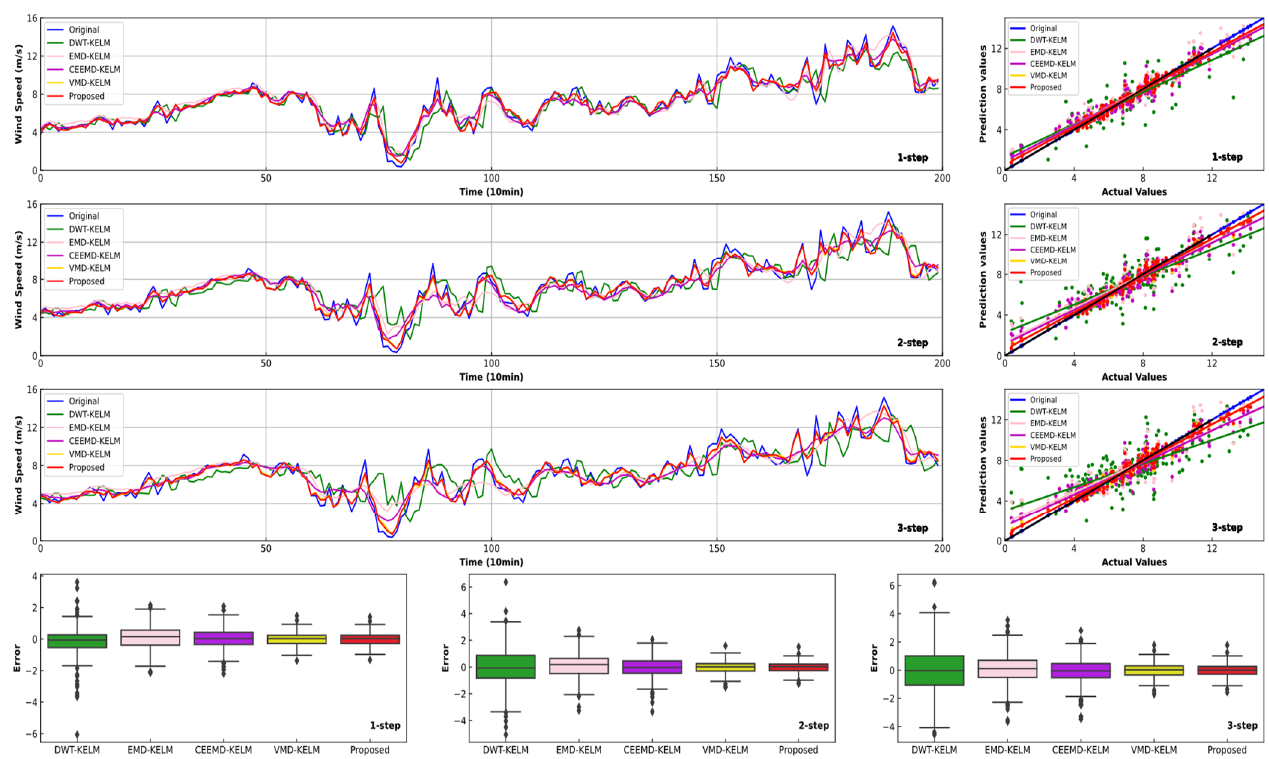
Figure 5. Forecasting performance of decomposed models in one-, two- and three-step ahead forecasting for the spring dataset.